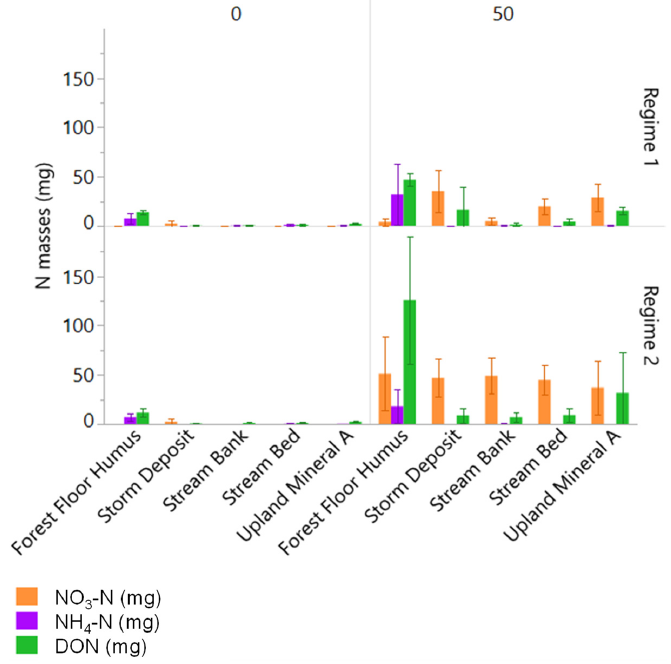
Figure 4. Porewater masses of N species for the five sources and two moisture regimes for day 0 and day 50. Regime 1: continuously moist and regime 2: dry–wet cycle.